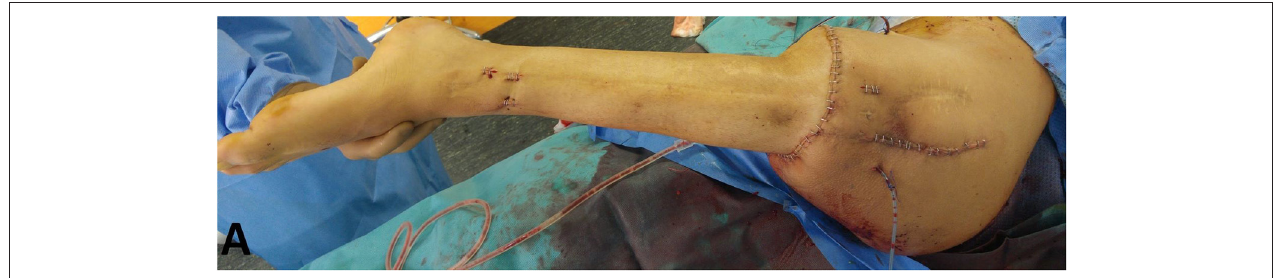
FIGURE 5 | Intra-operative aspect, after wound